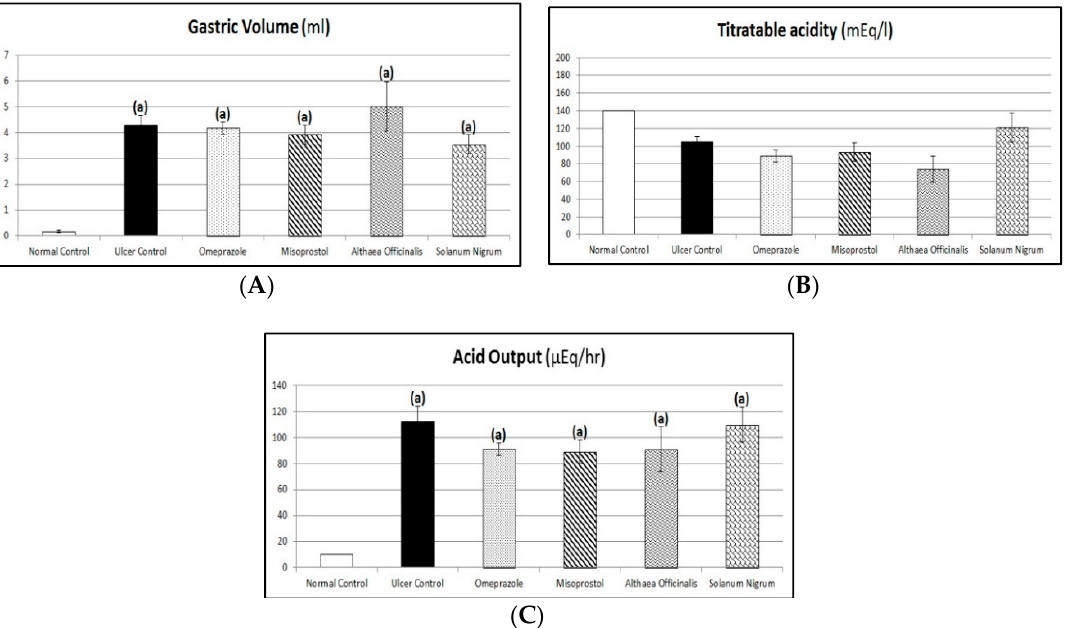
Figure 6. Protective effects of Althaea officinalis and Solanum nigrum with standards misoprostol and omeprazole on gastric volume ( A ), titratable acidity ( B ), and acid output ( C ) against pyloric-ligation / indomethacin-induced gastric-ulceration experimentally in male rats. Each